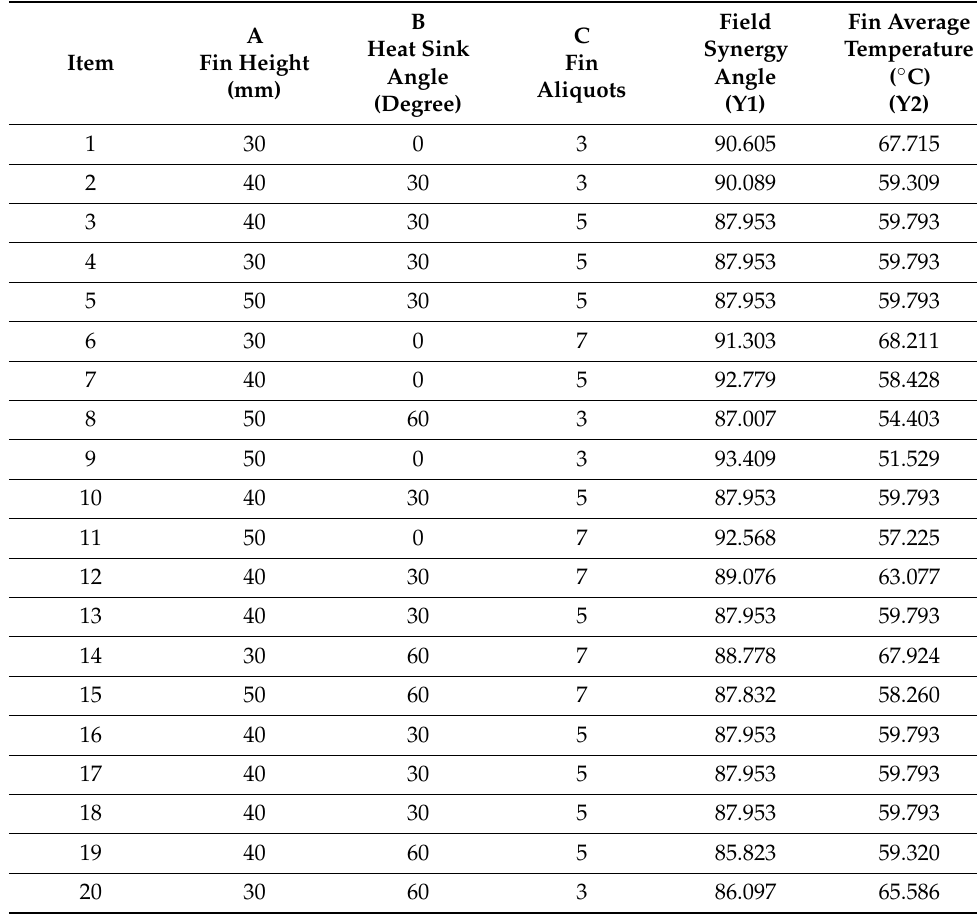
Table 3. Response surface experiment design.